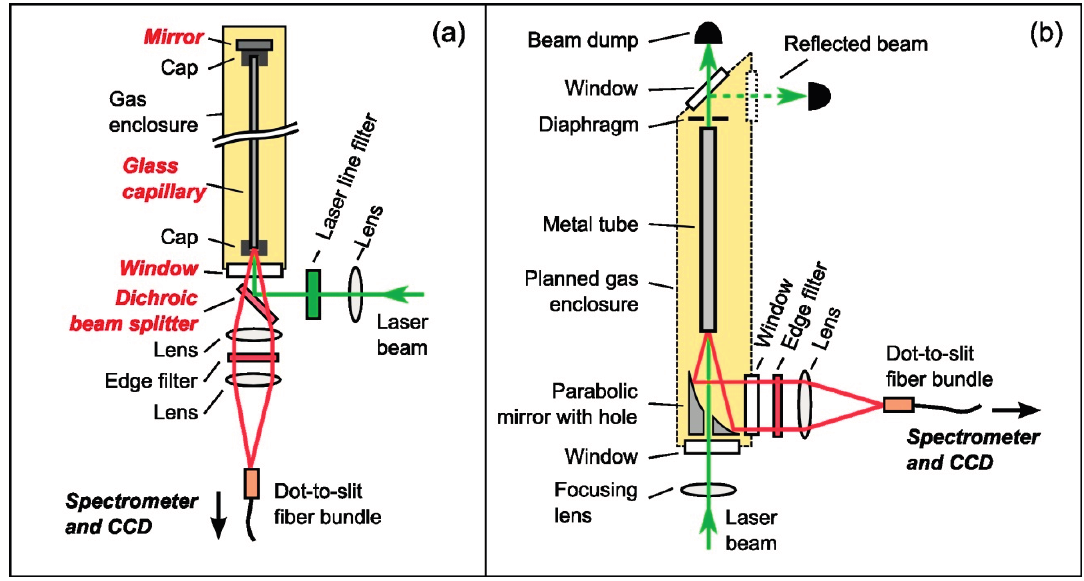
Figure 1. Schematic sketches of the capillary Raman spectroscopy setups. ( a ) The original system used in our laboratory [11,12]; the optical elements annotated in red contribute to the fluorescence background; ( b ) The improved setup resulting from this study; for details see